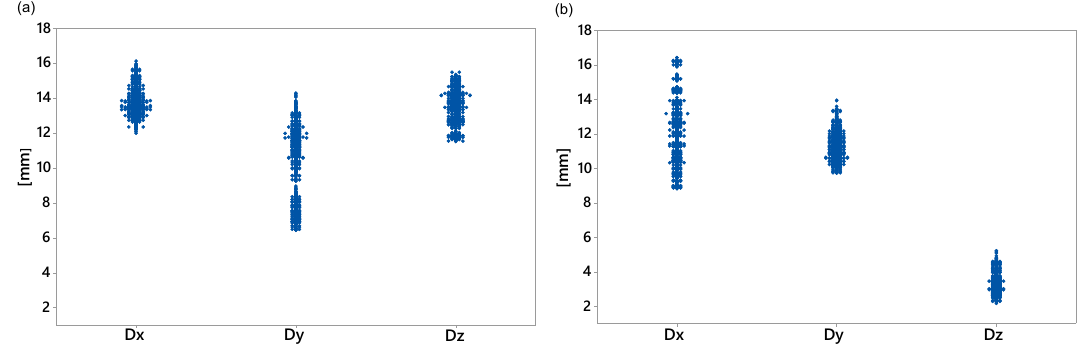
Figure 10. Maximum displacements of point closest to detergent box: ( a ) middle load; ( b ) counter